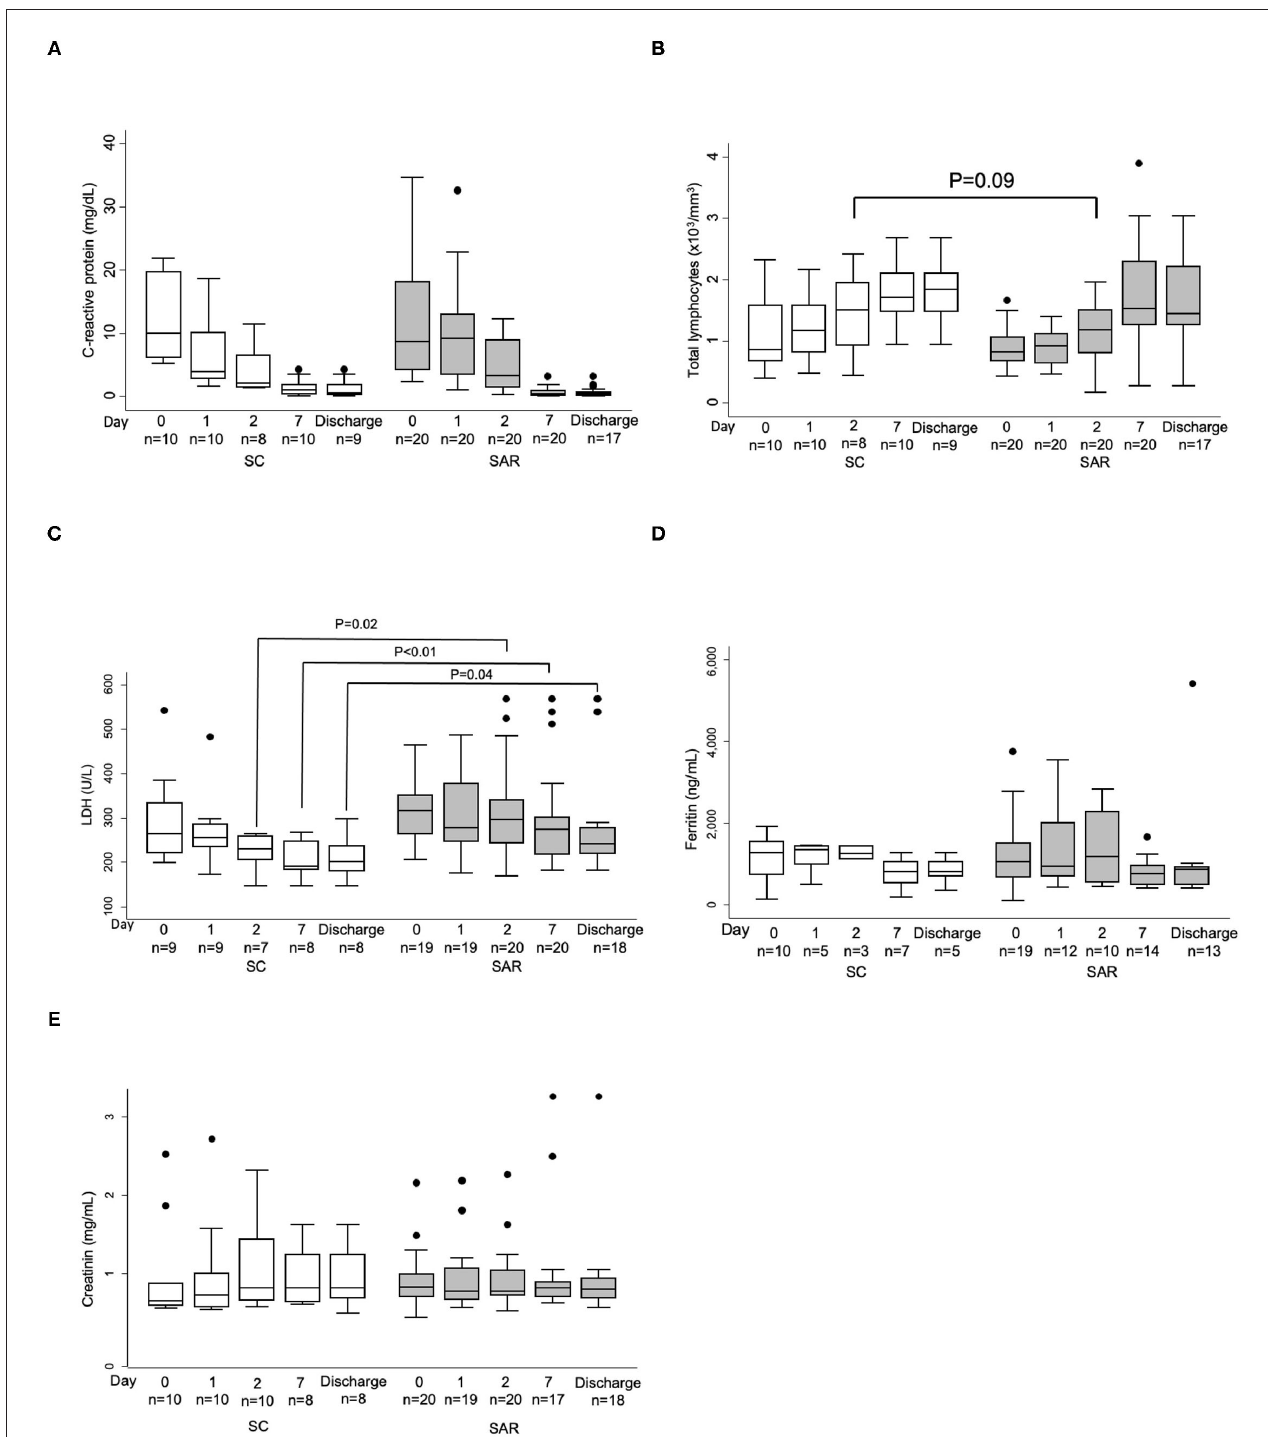
FIGURE 4 | Evolution of laboratory parameters throughout study visits. (A) C reactive Protein; (B) Total lymphocyte count; (C) Lactate dehydrogenase; (D) Ferritin; (E) Creatinin. Patients from standard care (SC; white boxes) and sarilumab (SAR; gray boxes). Only values available at each time point is shown and results are displayed as the interquartile range (p75 upper edge of the box, p25 lower edge, p50 midline) as well as the p95 (line above box) and p5 (line below). Dots represent outliers.